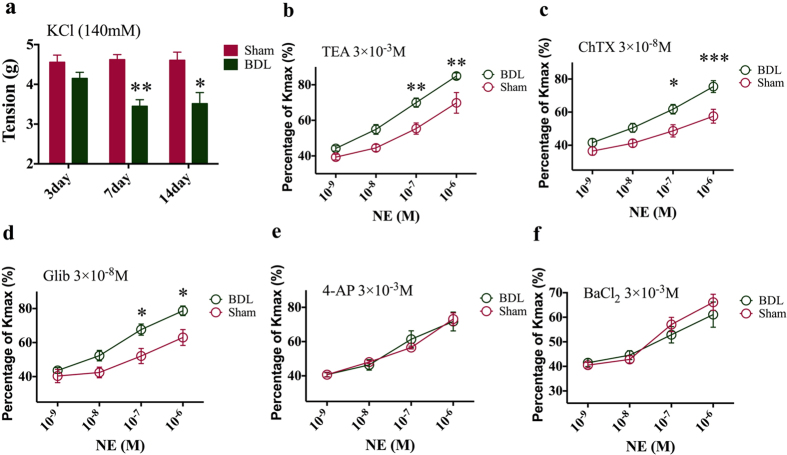
MaxiK and KATP in vascular smooth muscle cells played a critical role in vasoconstrictor hyporeactivity of BDL rats.(a) Vascular contractile response to KCl (140 mM) in 3, 7 and 14-day BDL or Sham rats. (b) Percentage of norepinephrine-induced contraction with TEA pretreatment in potassium-induced maximum contraction (Kmax) in 7-day Sham and BDL rats. (c) Percentage of norepinephrine-induced contraction with ChTX pretreatment in Kmax in 7-day Sham and BDL rats. (d) Percentage of norepinephrine-induced contraction with Glib pretreatment in Kmax in 7-day Sham and BDL rats. (e) Percentage of norepinephrine-induced contraction with 4-AP pretreatment in Kmax in 7-day Sham and BDL rats. (f) Percentage of norepinephrine-induced contraction with BaCl2 pretreatment in Kmax in 7-day Sham and BDL rats. *Represents p < 0.05, **p < 0.01, ***p < 0.001.